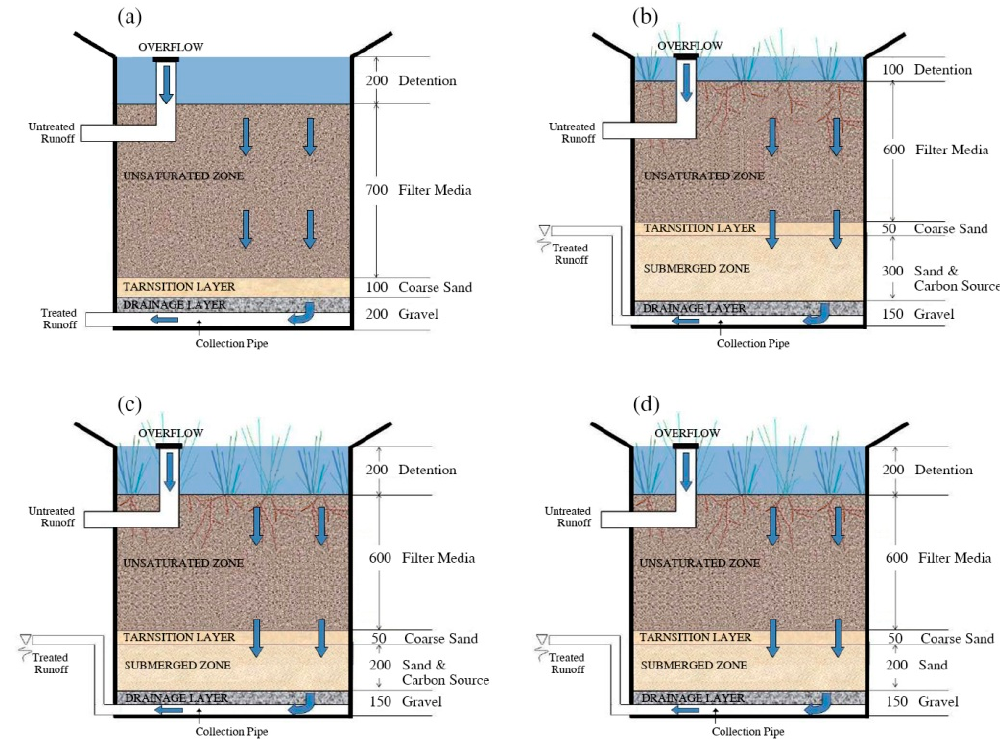
Figure 1. Layout of four bioretention mesocosms (unit: mm). ( a ) module without plants or SZ; ( b ) module with plants, and a SZ (depth of 300 mm) with C; ( c ) module with plants, and a SZ (depth of 200 mm) with C; and ( d ) module with plants and a SZ (depth of 200 mm). These figures are referenced to FAWB (Facility for Advancing Water Biofiltration) Adoption Guidelines for Stormwater Biofiltration Systems [44].